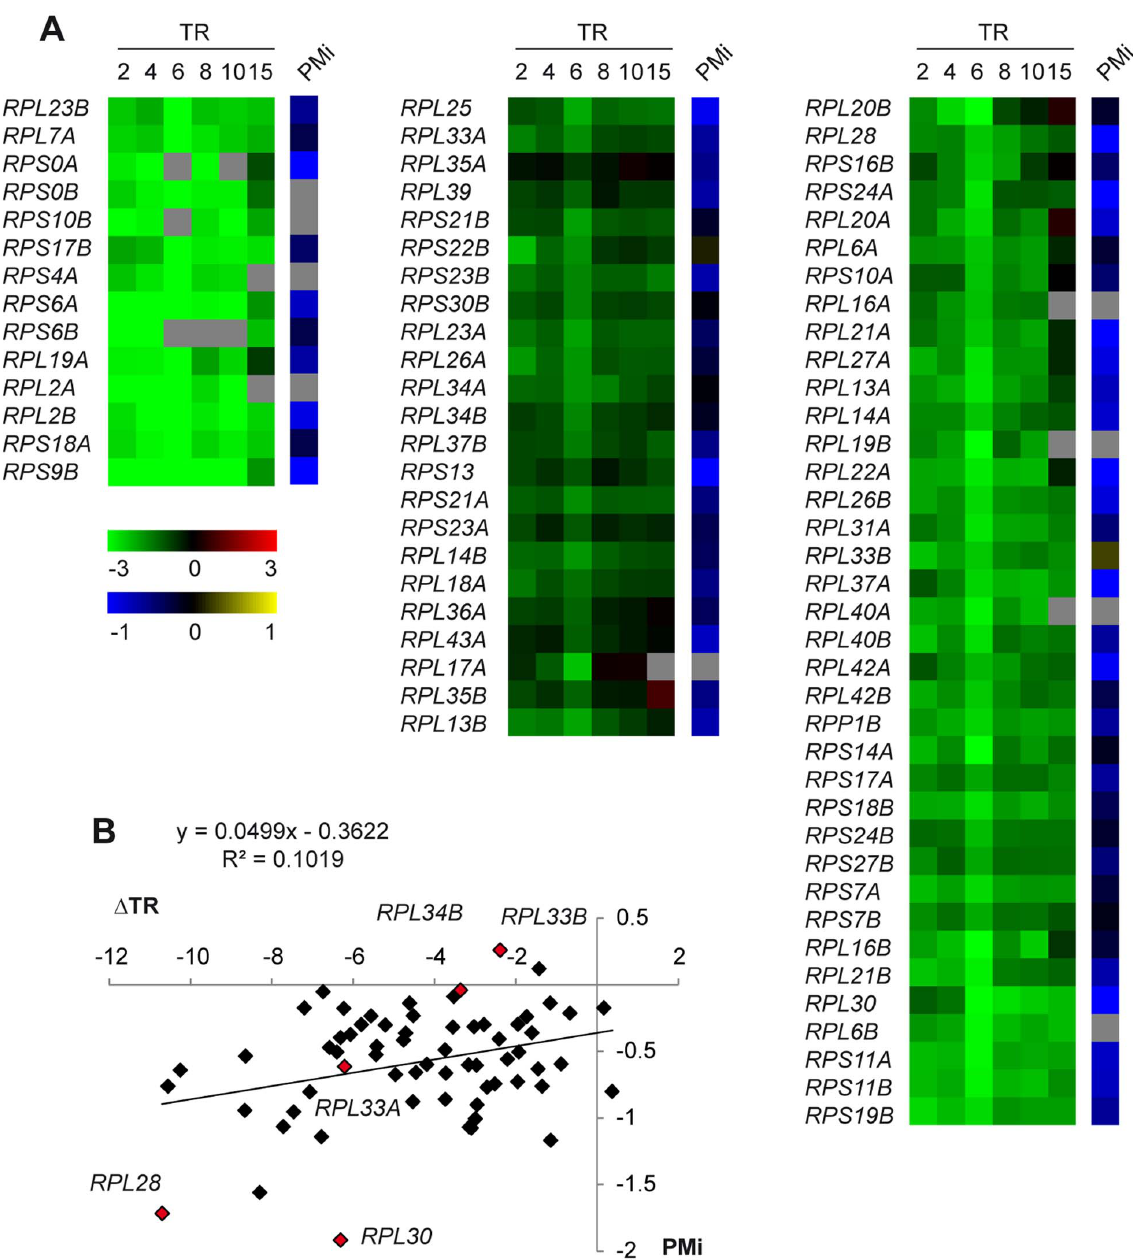
Figure 3. Analysis of the relation between ribosomal protein genes transcription and pre-mRNA processing during osmotic stress. (A) Clustering RP genes according to their transcription rate (TR) profiles. Wild-type cells were grown in YPD until the exponential phase and were then treated with 0.4 M NaCl. The samples taken at 0, 2, 4, 6, 8, 10 and 15 minutes of osmotic shock were processed to measure the TR of all the yeast genes. The data set series for intron-containing RP genes refers to their respective 0 time on a logarithm scale. A relative repression (stress/non-stress ratio, on the log 2 scale) is shown in green (saturated green indicates a decrease of at least 6-fold) and relative induction is depicted red (saturated red indicates an increase of at least 6-fold). RP genes were ordered and grouped into three distinct subclasses by K-means clustering using Euclidean distance. The PMi for all the RP genes are represented in the left panel using a blue-yellow heat map (saturated blue indicates a PMi of #2 1, while saturated yellow indicates a PMi of $ 1). Grey squares indicate missing values. (B) Comparison of RP genes D TR and their PMi in the cells treated with 0.4 M NaCl for 15 minutes related to non-stressed cells. The regression line, equation and correlation coefficient are shown in the graph. The RP genes that have been analyzed by quantitative RT-PCR are indicated as red diamonds. doi:10.1371/journal.pone.0061240.g003 degradation rate during osmotic stress since the RP gene PMi type strain under normal conditions and also during response to values were close to zero in those cells with a mutation in the osmotic stress. Additionally, although the change in the intron/ XRN1 or UPF1 decay factors. Moreover, our results indicate that exon ratios during osmotic stress was affected for specific RP genes the NMD pathway controls the RP pre-mRNA levels in the wild- in mutant rrp6, the nuclear degradation of RP pre-mRNAs by